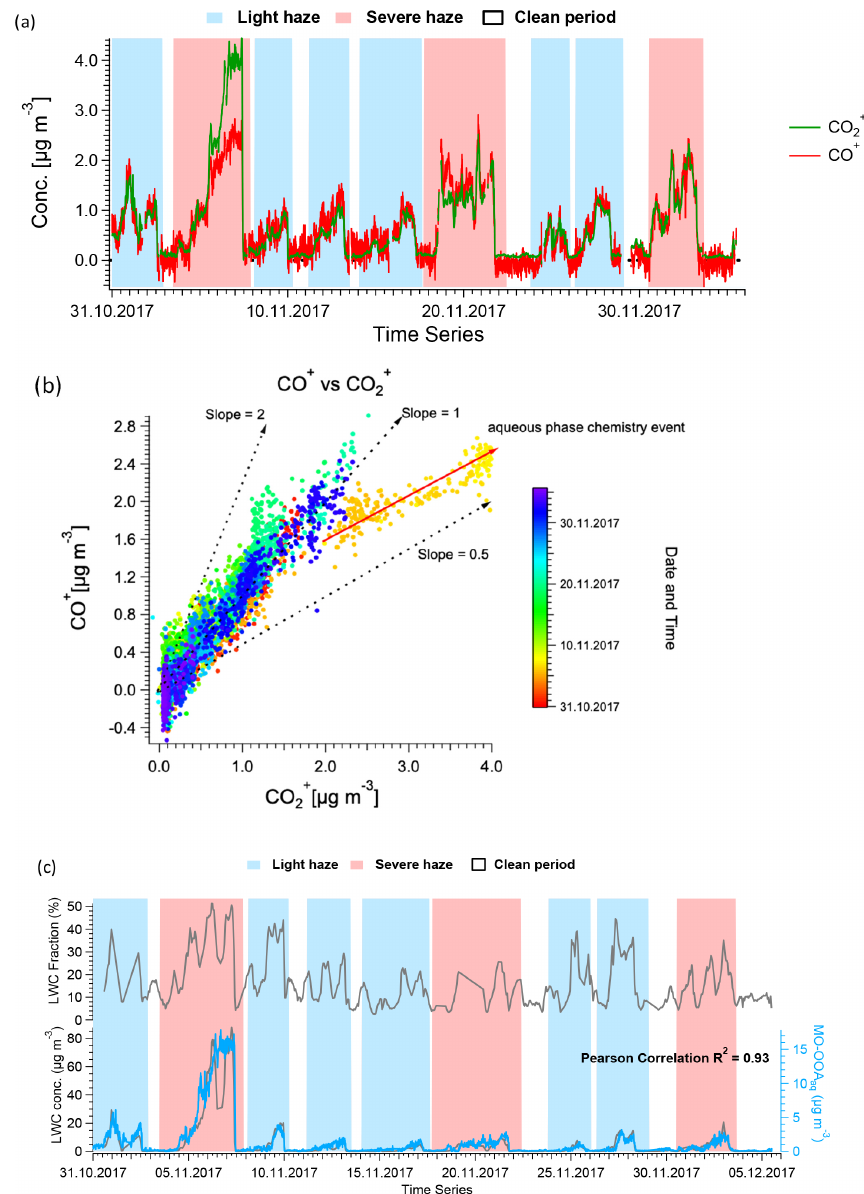
Figure 10. (a) Time series of AMS-measured CO + and CO + throughout the campaign. (b) Scatter plot of CO + and CO + , indicating a 2 2 different slope for the haze event between 4 and 7 November 2017, suggesting aqueous-phase chemistry may happen in this period. (c) Time series of LWC, both in fraction (top) and mass concentration (bottom), complemented by MO-OOA aq , demonstrating the high correlation between the latter two variables. In (a) and (c) , the shaded areas in red and in blue represent severe and light haze periods, respectively.